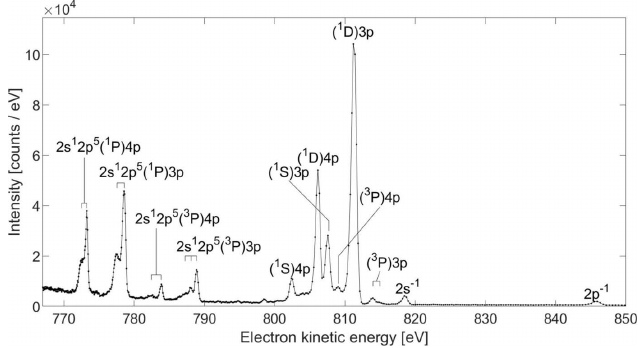
Figure 4 Resonant Auger spectrum of Ne following the 1s (cid:2) 1 3 p excitation at 867.17 eV, with 750 V retardation, measured at the storage